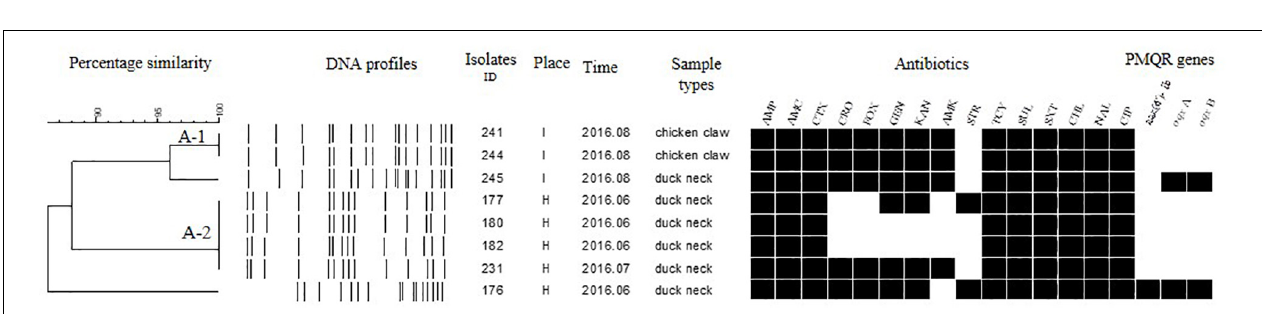
FIGURE 5 | Dendrogram of PFGE profiles for 9 S. Mbandaka isolates, their antibiotic resistance, and PMQR genes. Antibitics: Ampicillin (AMP), Amoxicillin-clavulanic acid (AMC), Ceftiofur (CTX), Ceftriaxone (CRO), Cefoxitin (FOX), Gentamicin (GEN), Kanamycin (KAN), Amikacin (AMK), Streptomycin (STR), Tetracyclines (TCY), Sulfisoxazole (SUL), Trimethoprim/sulfamethoxazole (SXT), Chloramphenicol (CHL), Nalidixic acid (NAL), and Ciprofloxacin (CIP).